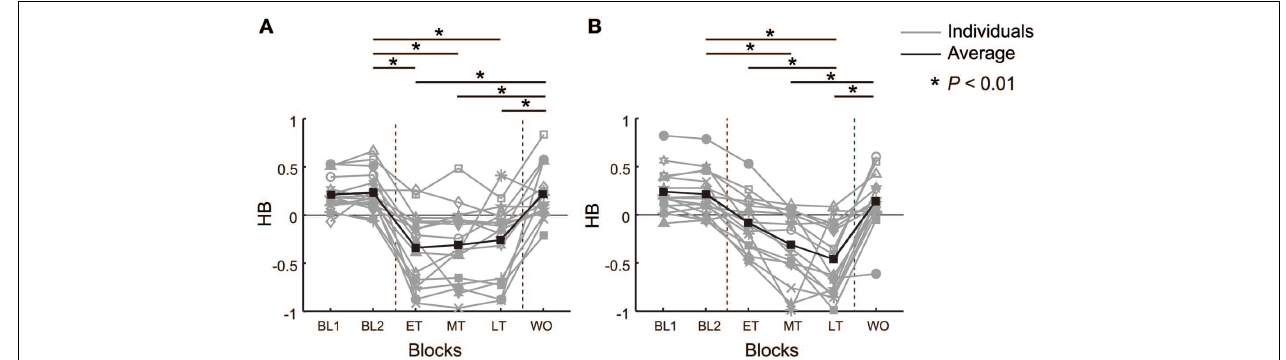
FIGURE 3 | HB in the abrupt and gradual condition from the baseline blocks (BL1, BL2), early training block (ET), middle training block (MT), late training block (LT), and the washout block (WO). Gray lines indicate HB of individual participants and black lines indicate the average